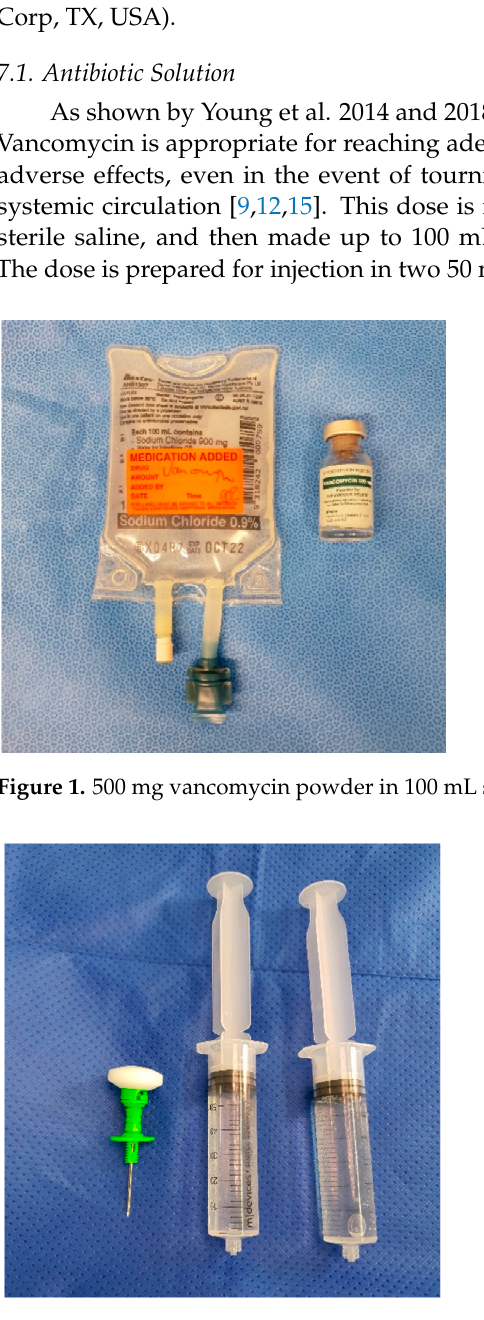
Figure 2. Solution prepared in 50 mL syringes.